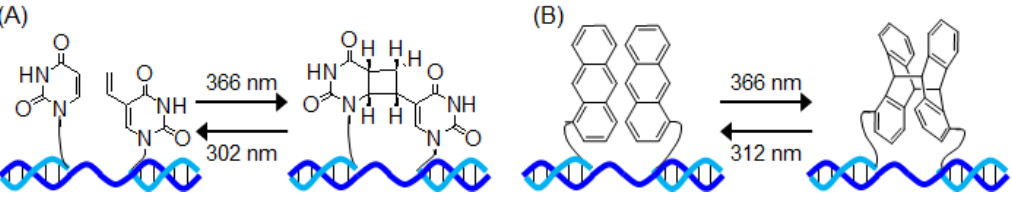
Figure 1. Reversible photoligation. ( A ) [2+2] cycloaddition and ( B ) [4+4]